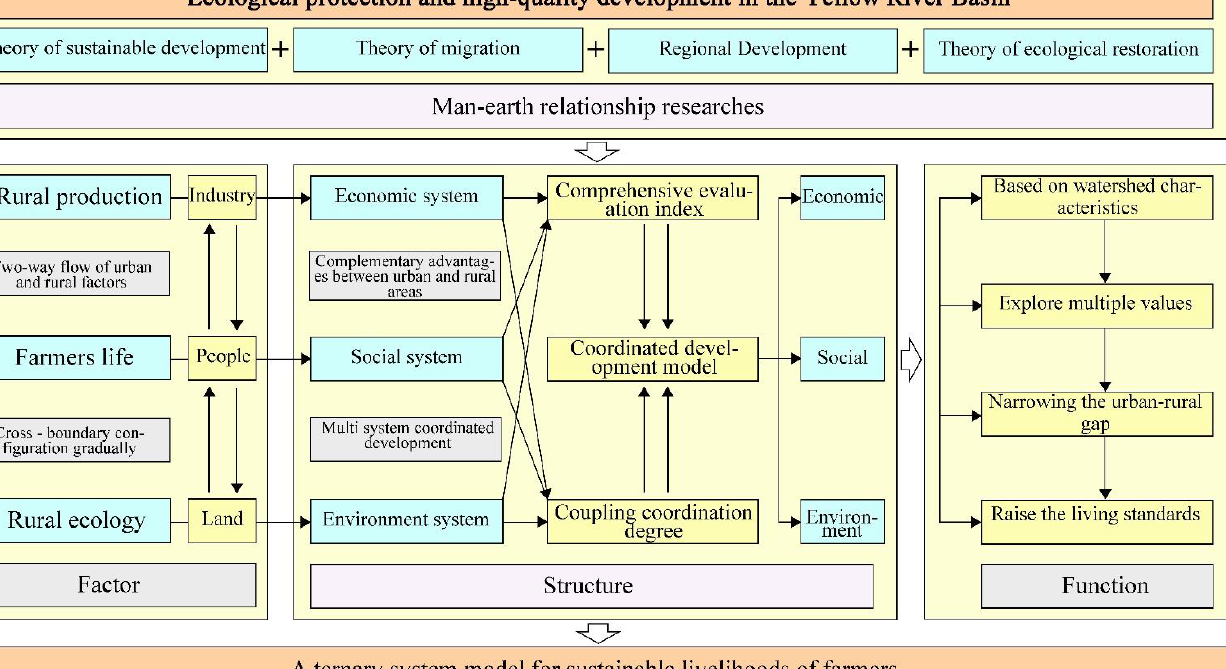
Figure 1. “Ternary” system model of farmers’ sustainable livelihood.